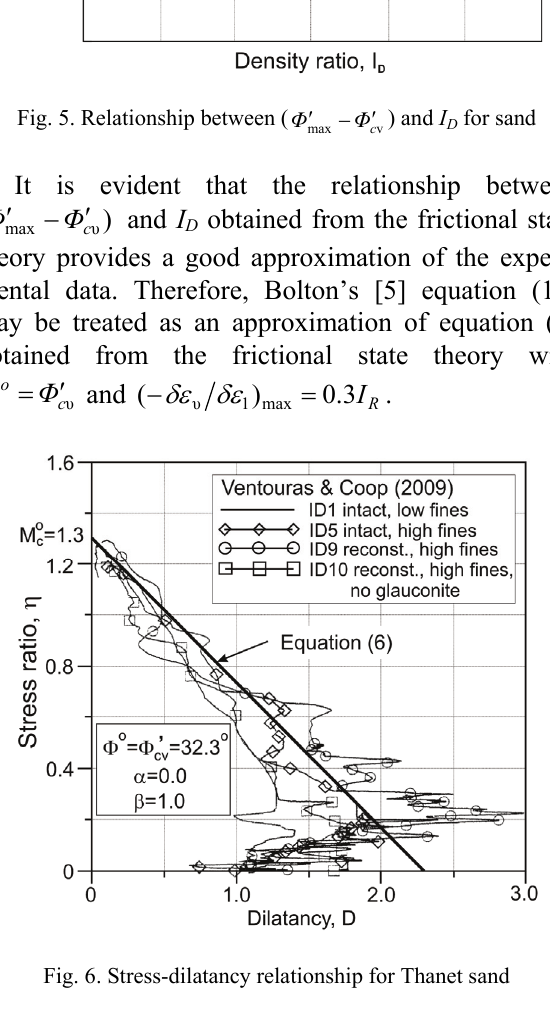
Fig. 5. Relationship between (